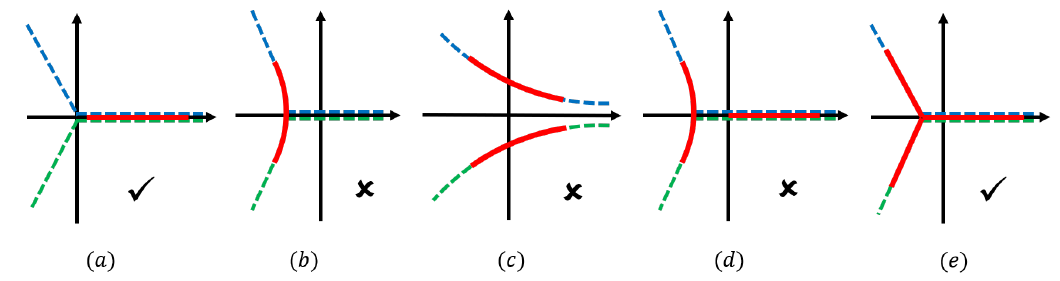
Figure 21. The red curves specify the possible cut shapes for D ρ in the complex E plane. The blue dashed line is C + , which connects e 2 πi/ 3 ∞ to + ∞ , and the green dashed line is C − , which connects e − 2 πi/ 3 ∞ to + ∞ . (a)(b) are one-cut configurations, and (c)(d)(e) are two-cut configurations. Only (a) and (e) are solutions to our cubic potential matrix